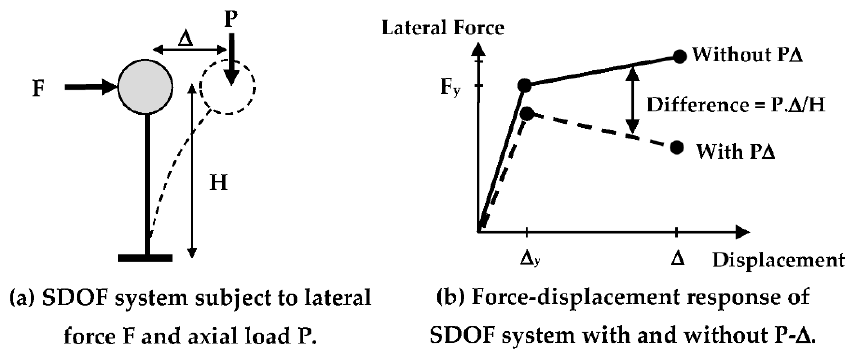
Figure 4. Influence of second-order P-delta effect on the lateral force-displacement response of a SDOF system (Adopted with permission from [13]. Copyright 2013 IUSS press; F is the total lateral force equivalent to base shear before considering geometric nonlinearity) .